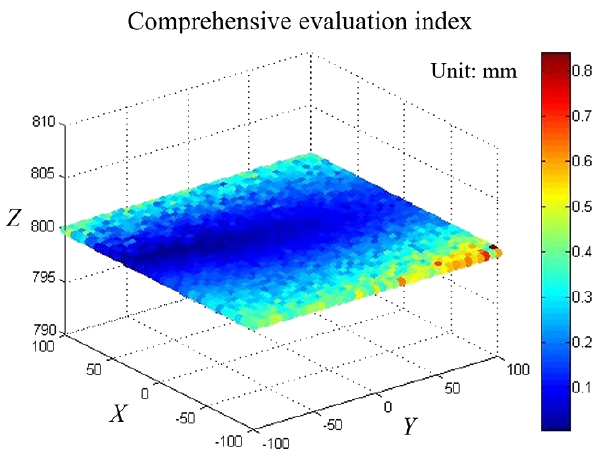
Figure 14. When z = 800mm, the influence of position error caused by